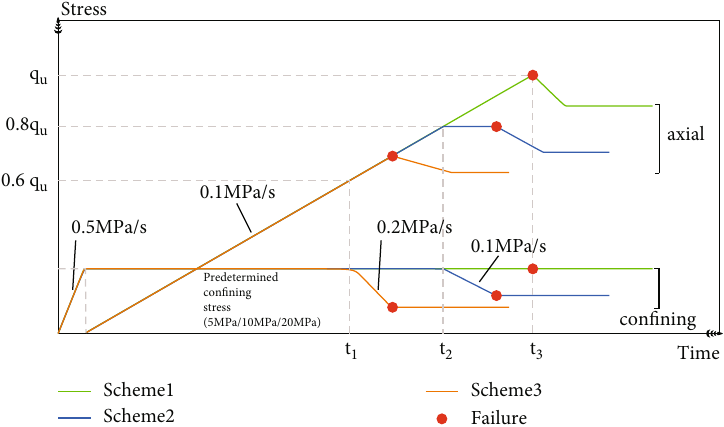
ff erent con fi ning pressures in Figure 3: The experimental design of three stress paths ( q u is the peak compressive strength under di Scheme 1; t 1 and t 2 represent the moment when the con fi ning pressure in Schemes 3 and 2 begins to change, and t 3 represents the moment when the sample in Scheme 1 is in peak